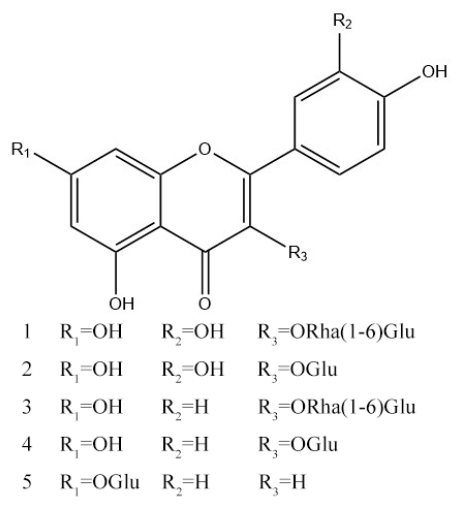
Figure 1. Chemical structures of compounds 1 – 5 .